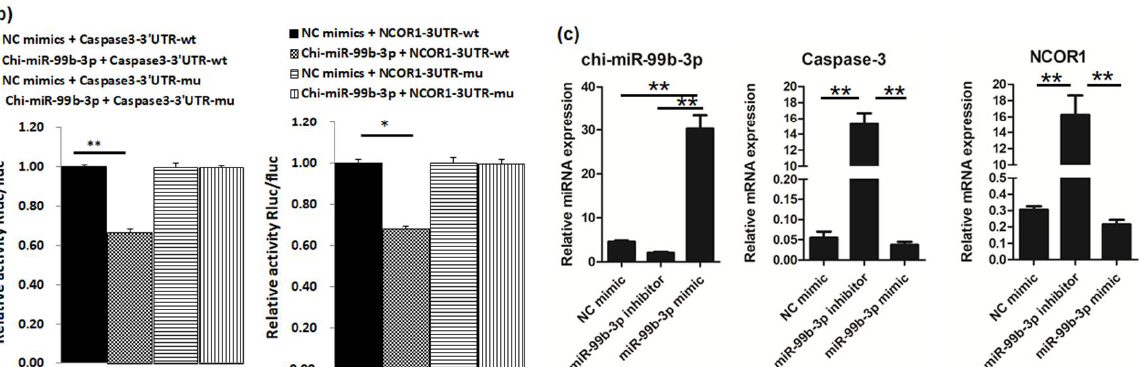
Figure 2. Caspase-3 and NCOR1 are the target genes of chi-miR-99b-3p. ( a ) Diagram depicting the binding sites of chi-miR-99b-3p on the 3 (cid:48) -UTR of Caspase-3 and NCOR1 (highlighted in red). ( b ) Detection of relative luciferase activity. wt, wild-type. mut, mutant-type. All results are presented as means ± SEM. n = 3. * p < 0.05; ** p < 0.01. ( c ) Overexpression or suppression of chi-miR-99b-3p impacted the expressions of Caspase - 3 and NCOR1 at the mRNA level.